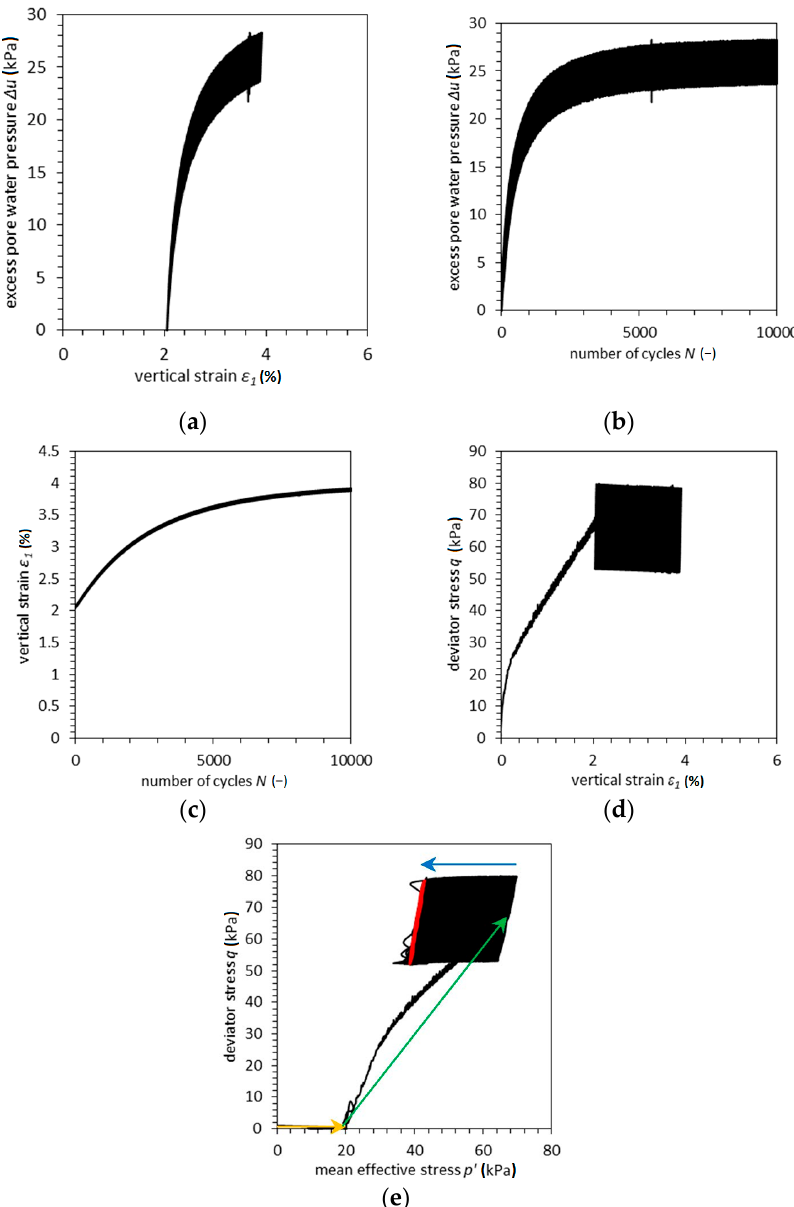
Figure 9. Results of the cyclic triaxial test for sandy silty clay under a confining pressure of 44.9 kPa and under the K 0 consolidation, initial void ratio e 0 = 0.400, K 0 = 1.00—sample 2.5: ( a ) Excess pore water pressure versus vertical strain characteristic, ( b ) excess pore water pressure characteristic versus number of cycles, ( c ) vertical strain characteristic versus number of cycles, ( d ) deviator stress–vertical strain relationship, and ( e ) the deviator stress–mean effective stress relationship (red color—last 10 cycles; arrow color—violet: Saturation phase, green: Consolidation phase, blue: Cyclic loading program).